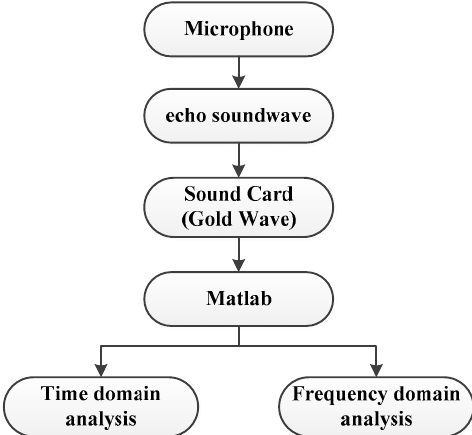
Figure 5. Schematic of hardware–software connection.